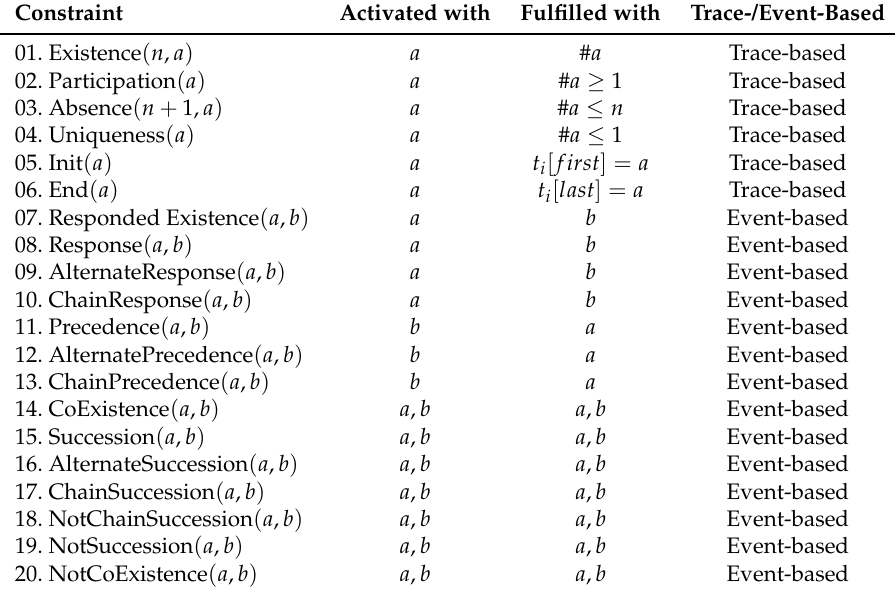
Table 4. Overview of all single-perspective constraints according to Di Ciccio and Mecella [12]. The symbol # represents the number of occurrences of the following event. The notation t i [ first ] refers to the first event and t i [ last ] to the last event in the trace i in the log containing m ∈ N traces with i ∈ { 1,..., m }